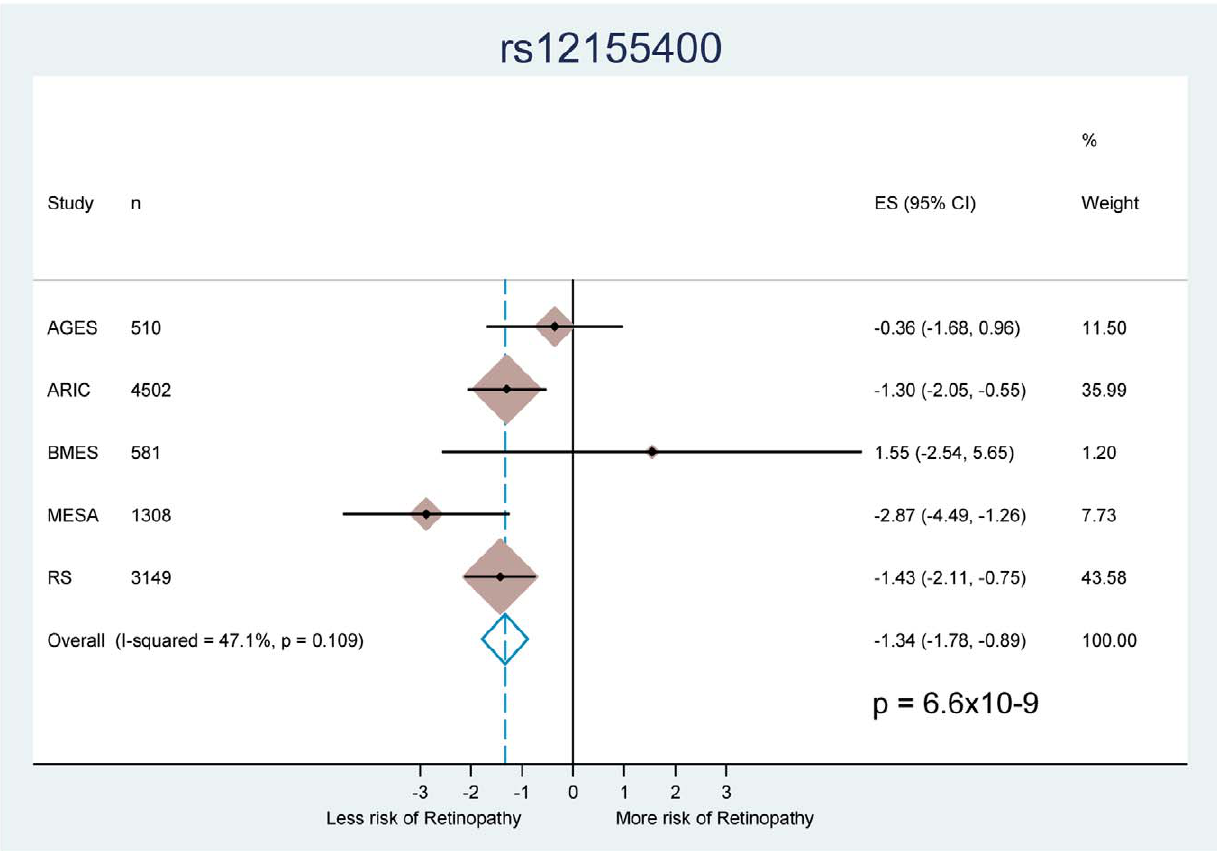
Figure 2. Forest plot. This figure display the direction, effect, 95% confidence interval, sample size and % weight from each individual discovery cohort and overall for the association between SNP rs12155400 on chromosome 7 and retinopathy defined as the presence of microaneurysms or dot-blot hemorrhages. The I 2 heterogeneity statistic is a measure of the percentage of variation attributable to differences in effect sizes between cohorts. Results from this SNP were not available in